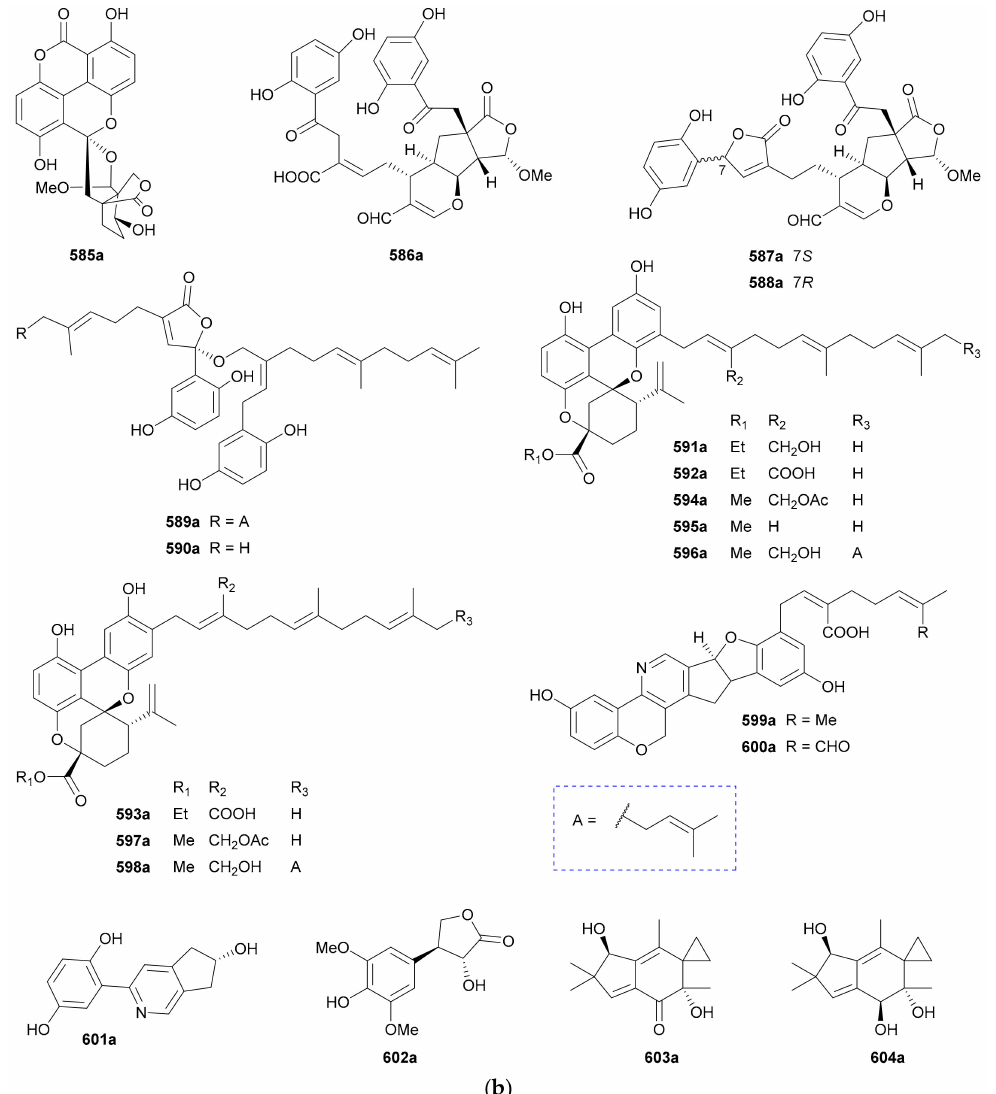
Figure 31. ( a ) Structures of metabolites from phylum Basidiomycota (Part 1); ( b ) Structures of metabolites from phylum Basidiomycota (Part